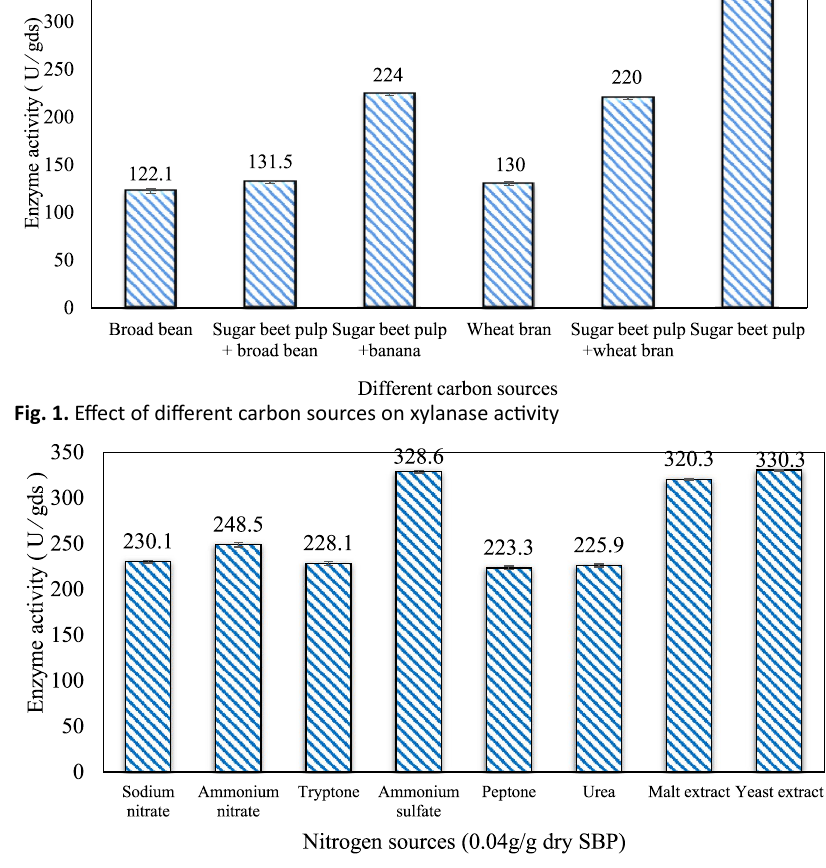
Fig. 2. Effect of different nitrogen sources on xylanase activity